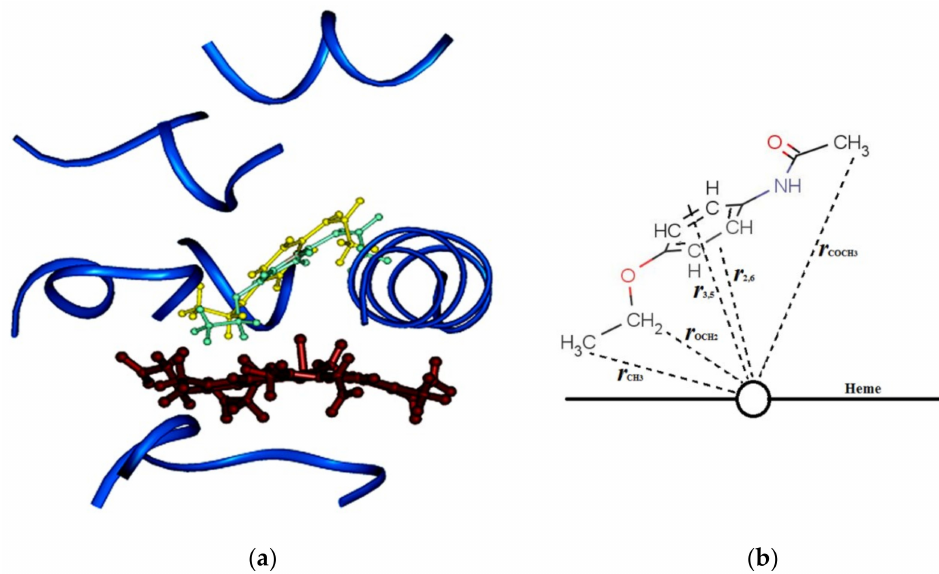
Figure 5. Binding of phenacetin in the active site of CYP1A2 WT and L382V. ( a ) A comparison of phenacetin binding orientations in CYP1A2 WT (substrate shown in yellow), and in CYP1A2 L382V (substrate shown in green). The enzymes were superimposed using the protein backbone as a basis; for clarity, the mutant enzyme is not displayed; ( b ) Cartoon representation of ( a ) to clearly show the distances of protons to heme iron. The heme is labeled and shown as a circle and a line, the distances of protons of phenacetin to heme iron are listed and represented by dotted